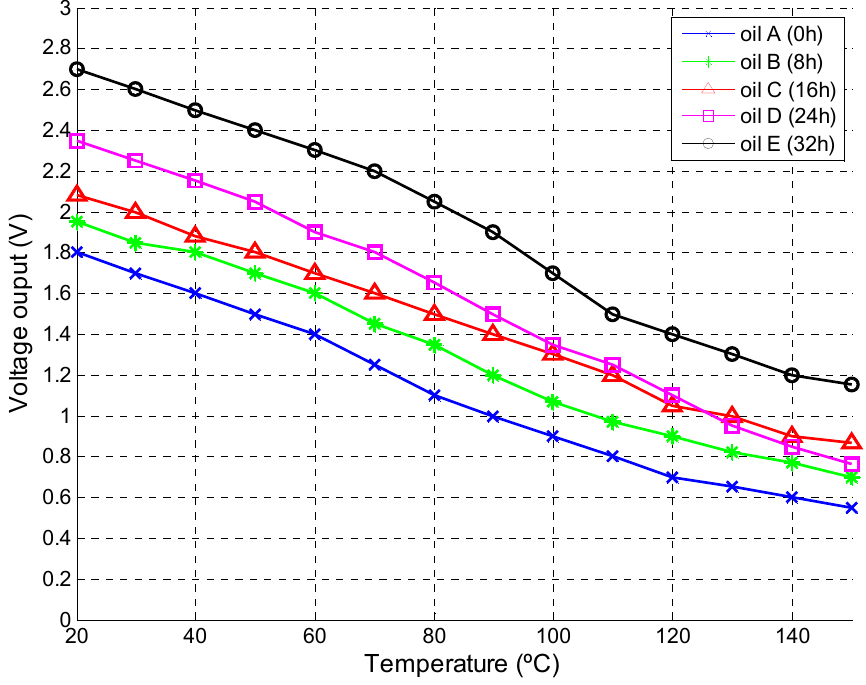
Figure 12. Sensor’s output voltage vs. temperature for different oil oxidation